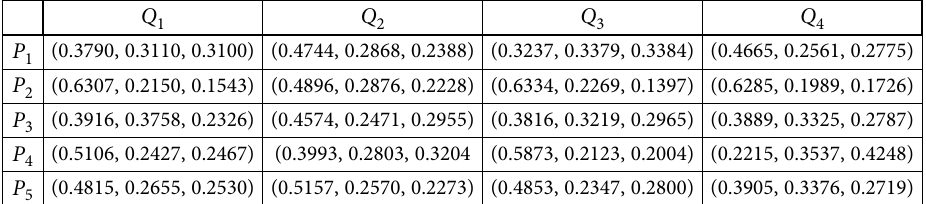
Table 4. Average picture fuzzy decision matrix